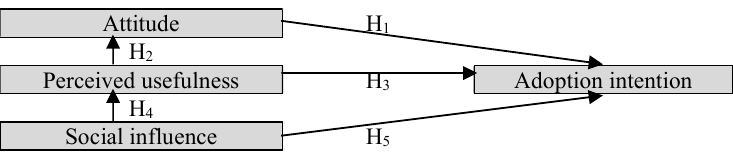
Fig. 1. The theoretical